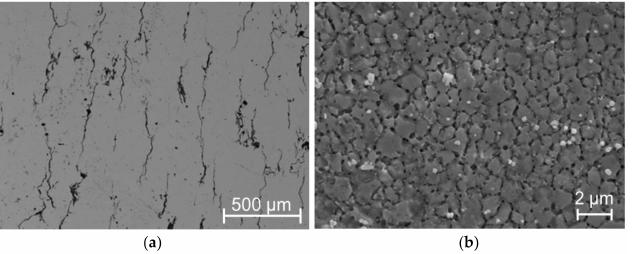
Figure 10. The 7075 alloy processed by L-PBF exhibits a columnar structure ( a ). After the addition of Nb particles (3%), the structure consists of ultrafine equiaxed grains ( b ). Adapted from ref. [120] (reproduced with permission from Additive Manufacturing; published by Elsevier,